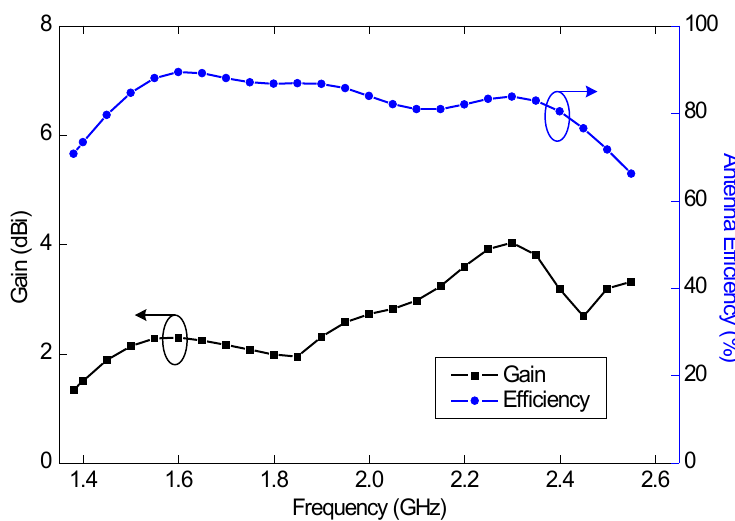
Figure 4. Predicted antenna efficiency and gain of the planar LSA antenna (Ant#1).